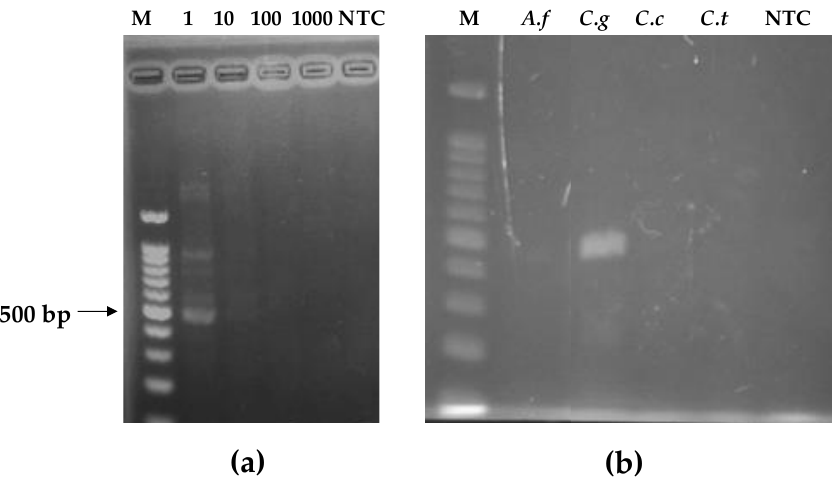
Figure 2. Electropherogram of PCR-amplified fungal DNA: ( a ) lane M—100 bp DNA marker; lane 1, clear visualization of C. gloeosp ; lanes 10, 100, and 1000, C. gloeosporioides DNA diluted 10, 100, and 1000 times, respectively; lane NTC, no-template control; ( b ) lane M—100 bp DNA marker; lane A.f = Aspergillus fumigatus ; lane C.g = C. gloeosporioides ; lane C.c = C. candidum ; lane C.t = C. theobromicola .